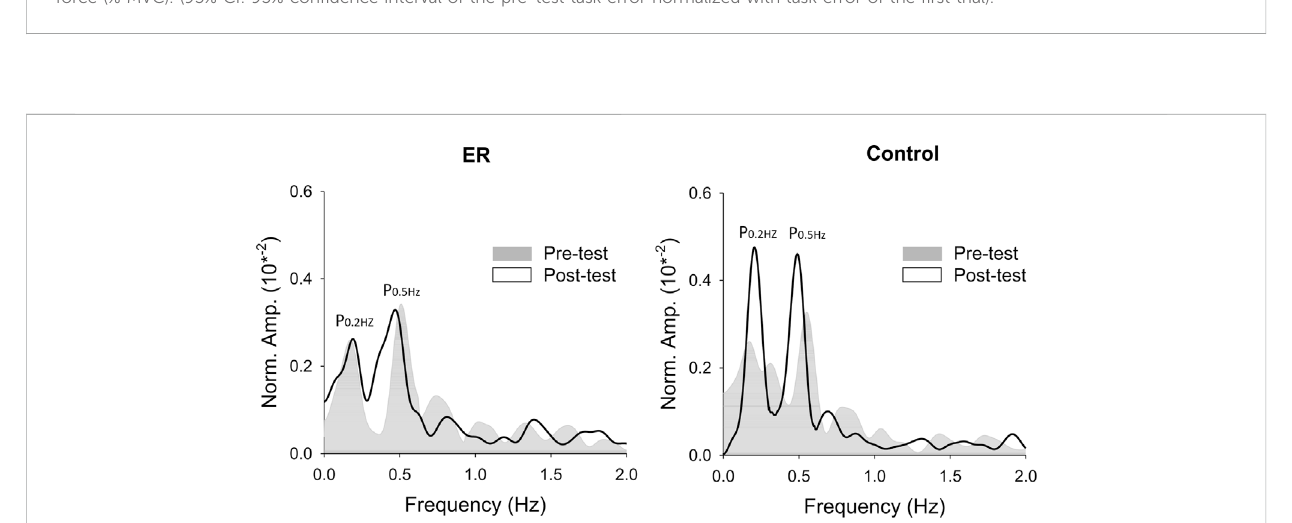
FIGURE 4 The contrast of pooled normalized power spectra of force tracking between the pre-test and post-test from representative subjects in the ER and control groups.